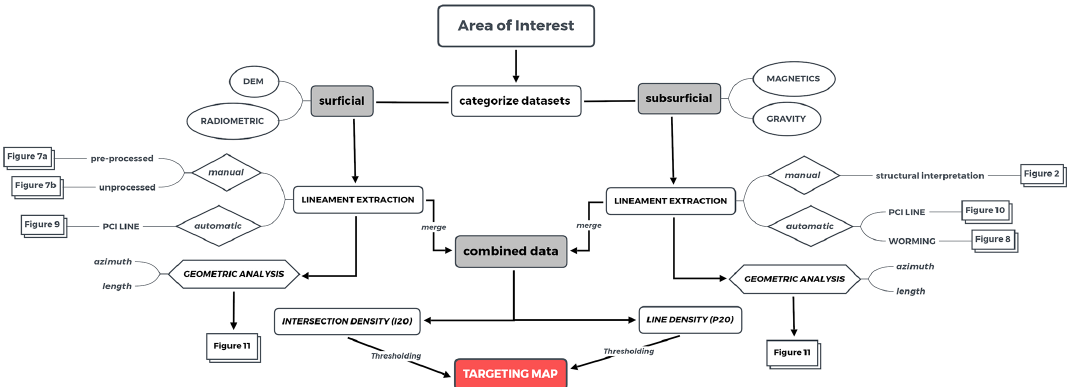
Figure A1. Detailed sketch of the workflow we followed in this study. To generate targeting maps, lineament maps derived from surface (DEM and radiometrics) and subsurface data (magnetics and gravity) are generated. We utilise different automated and manual methods to obtain these maps as outlined in Sect. 3. As part of this contribution, a geometric analysis is performed on each individual lineament set to highlight the variability in principal orientation and length. Lineaments representing superficial or subsurface features are merged if they are obtained with same extraction method (see Table 1). In the subsequent step, the combined data (see Table 2) are used to compute line density and intersection density. The targeting maps are then derived by applying a user-defined threshold in order to highlight the regions of interest. Note that in this publication we applied an uniform threshold to all datasets. In essence, the workflow comprises five subsequent steps: (1) categorise the data, (2) extract the lineaments, (3) combine surface and subsurface lineaments that are segmented by the same method but are derived from different data, (4) merge surface and subsurface lineament datasets into a combined dataset, and (5) compute density maps highlighting the regions of interest based on a defined